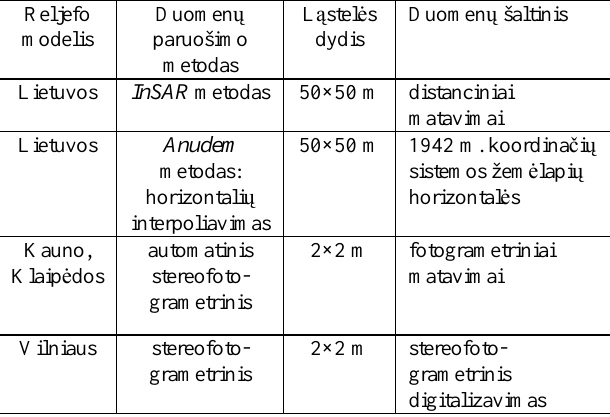
Table 1. The digital terrain models of